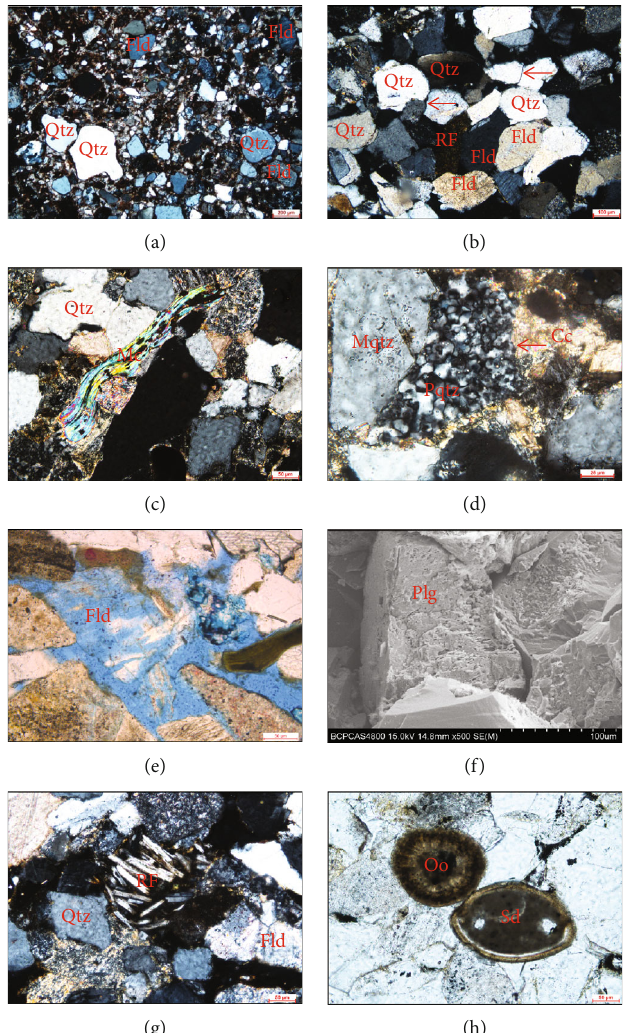
Figure 3: Lithological characteristics of the deeply buried Es sandstones in Raoyang Sag. (a) Well NG7: 4077.3 m, fi ne to medium grained 3 size with poor to moderate sorting, and subangular to subrounded grain shapes, XPL (crosspolarized light). (b) Well L101: 3705.8m, rigid grains presenting long and concave-convex contact relations (arrow), XPL. (c) Well L425: 3668.2m, mica containing ferruginous matters existing in samples, XPL. (d) Well L425: 3668.2m, monocrystalline quartz containing numerous inclusions and bits of polycrystalline quartz (chert) engulfed by carbonate cementation (arrow), XPL. (e) Well N201: 3775.9 m, intensively dissolved feldspar, PPL (plane- polarized light). (f) Well N70X: 3566.3m, feldspar dissolved along cleavages, SEM. (g) Well L101: 3796.0m, andesite fragment rich in feldspar with pilotaxitic texture, XPL. (h) Well Ng7: 4077.3 m, ooids and skeletal debris with intact shapes, PPL. Qtz: quartz; Fld: feldspar; RF: rock fragment; Cc: carbonate cements; Mc: mica; Mqtz: monocrystalline quartz; Pqtz: polycrystalline quartz; Plg: plagioclase; Oo: ooid; Sd: skeletal